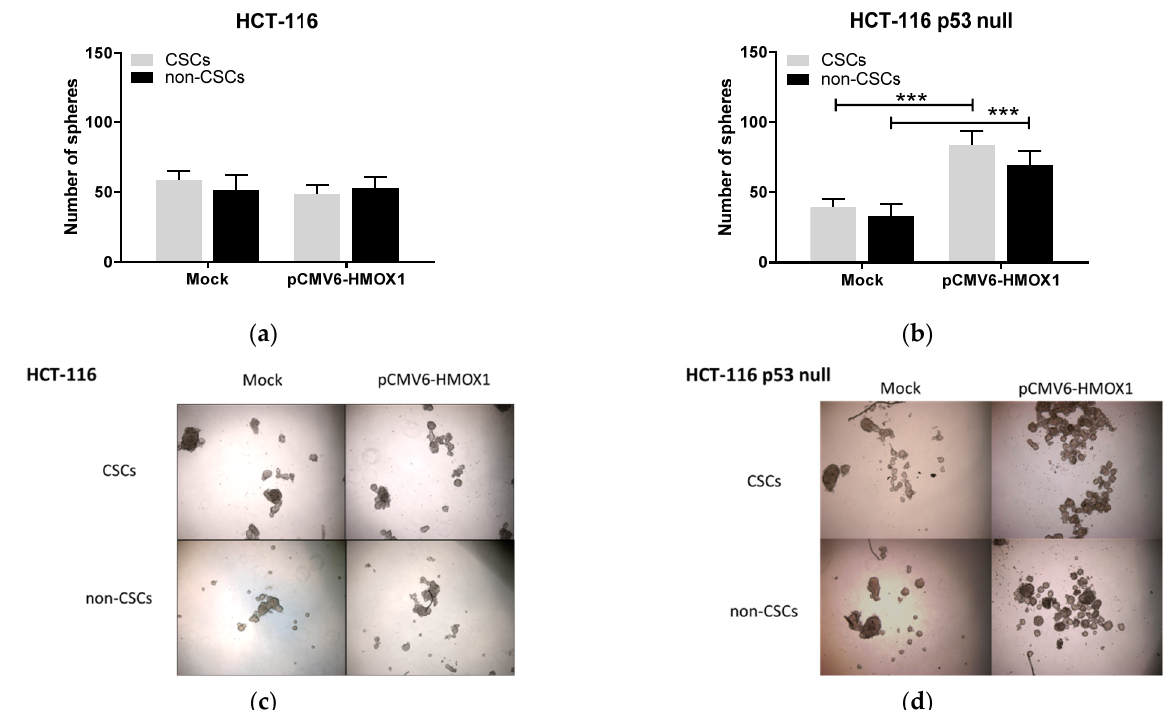
Figure 7. Blockade of endothelin-1 receptors eliminates the HO-1-induced self-renewal ability in p53 wild-type CRC cells and enhances it in p53 null cells. The number of spheres formed by subpopulations obtained from mock and pCMV6- HMOX1 ( a ) HCT-116 and ( b ) HCT-116 p53 null transiently transfected cells. Representative images of tumorospheres formed from different subpopulations of pCMV6- HMOX1 ( c ) HCT-116 and ( d ) HCT-116 p53 null transiently transfected cells. ***, p < 0.001.